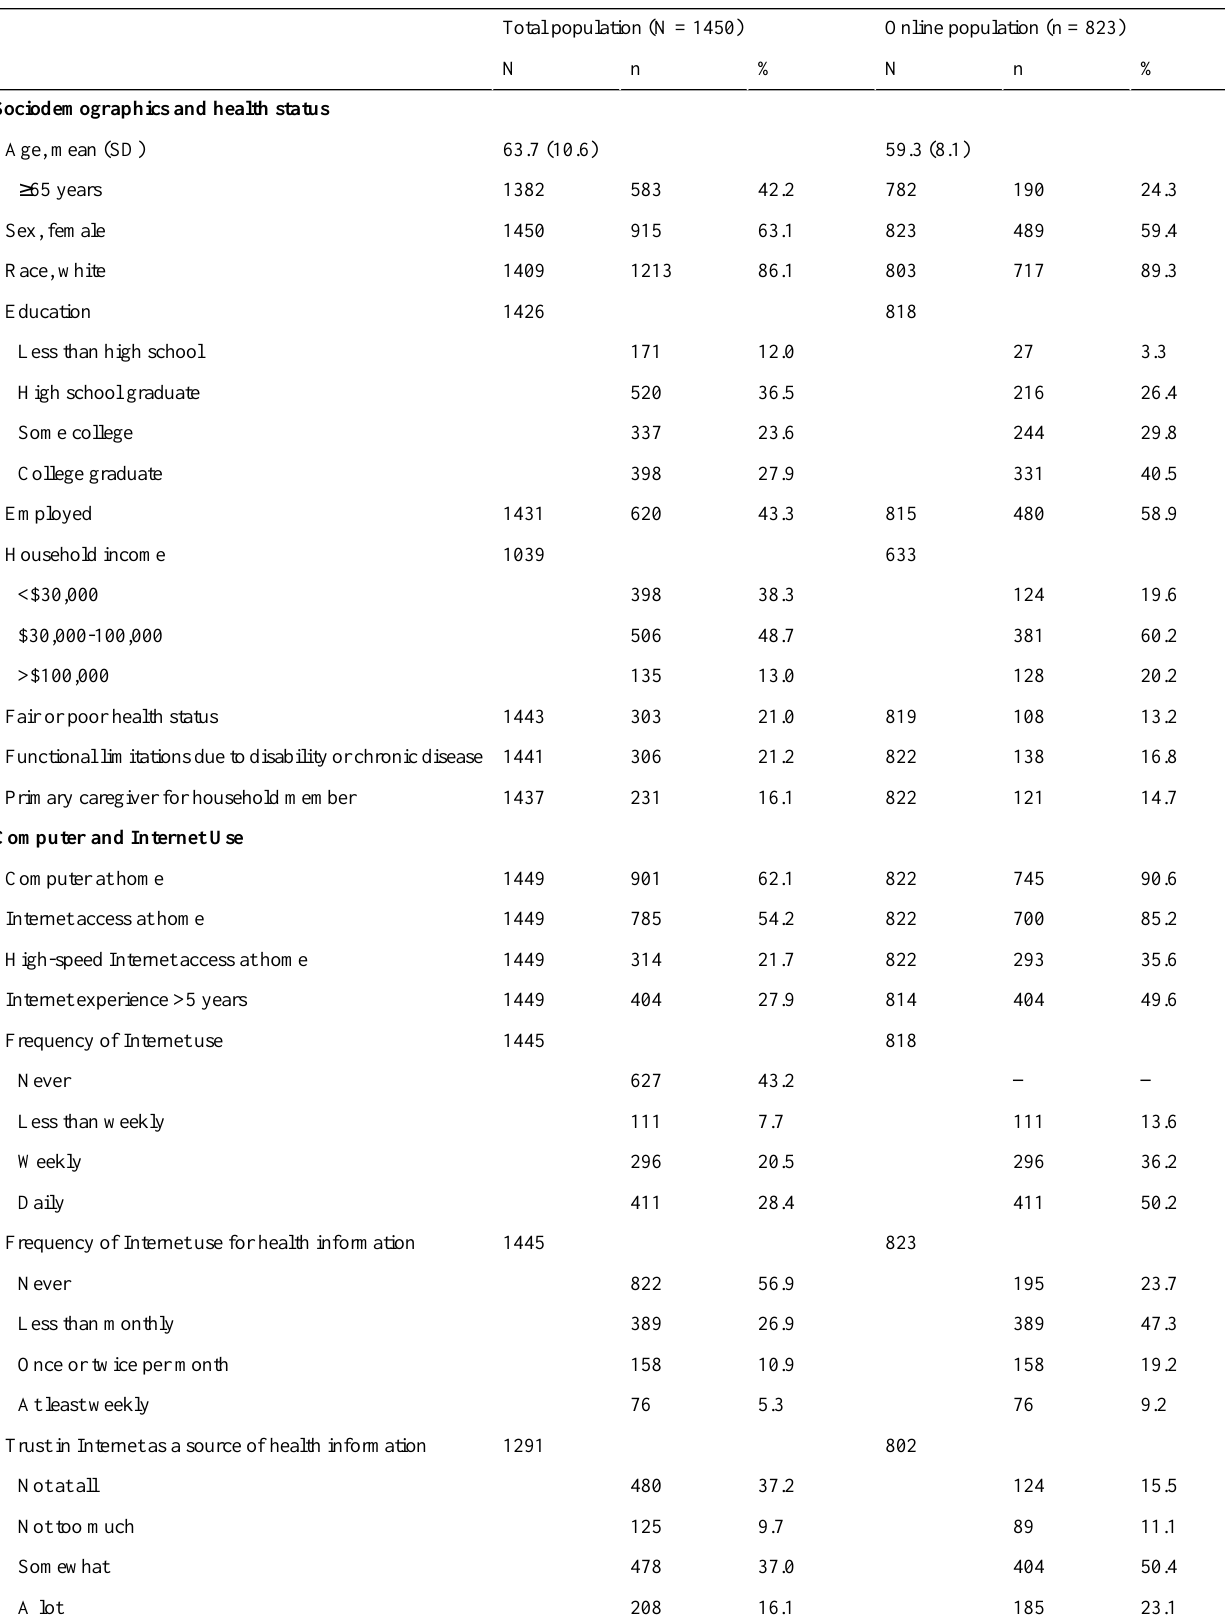
Table 1. Characteristics of the study population